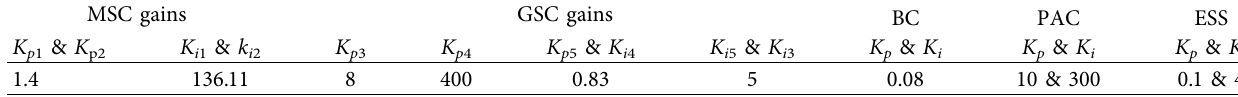
Table 10: Controller gains of the studied system [20,